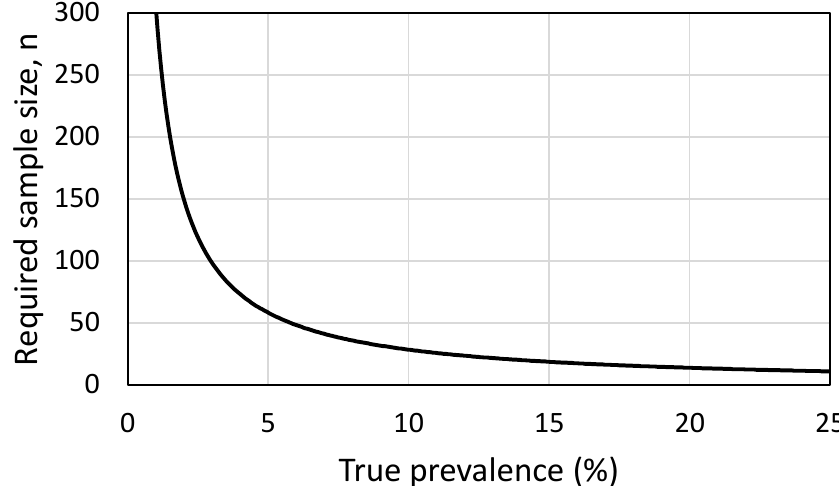
Figure 1. The sample size ( = number of slugs) required to detect at least one infected slug, given true prevalence from 1% ( n = 299) to 25% ( n = 11). Higher prevalence omitted for clarity: n declines further to 5 (at 50% prevalence) and 3 (75%).